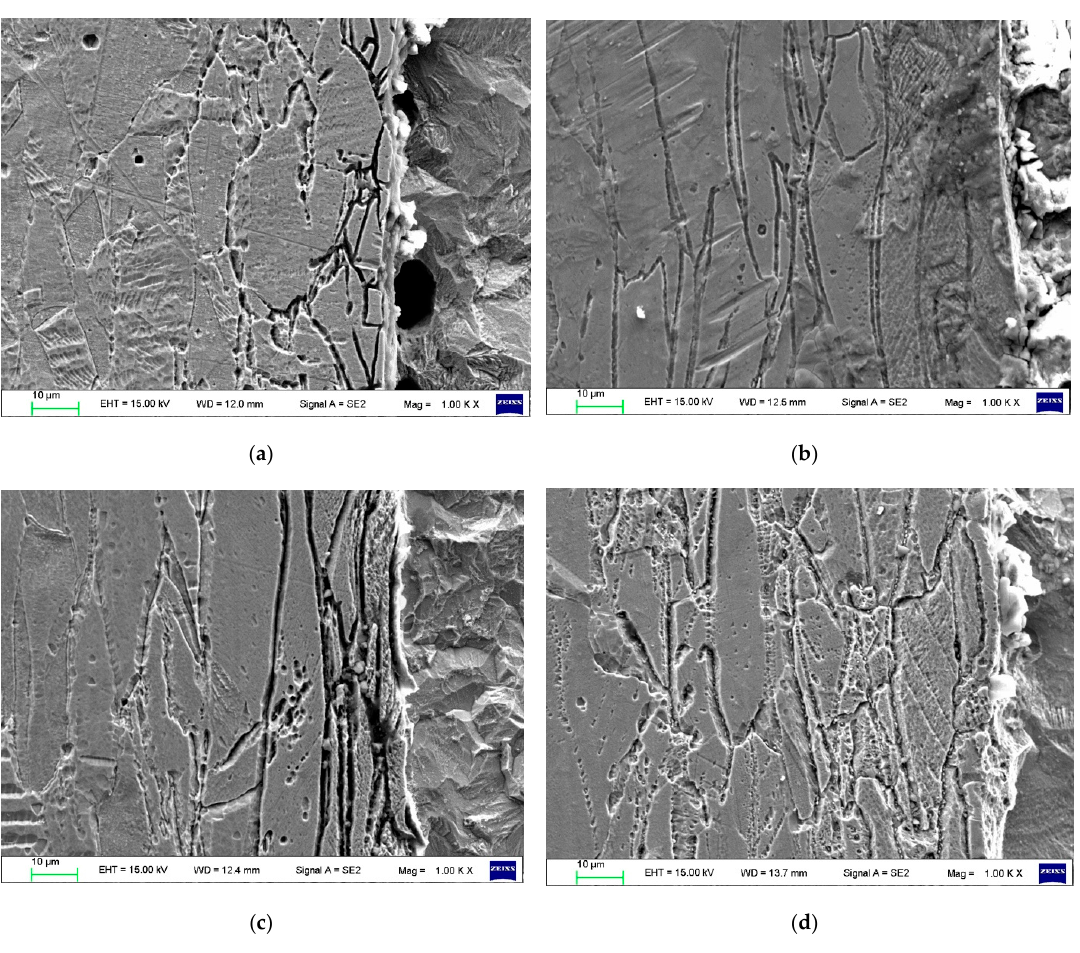
Figure 3. Microstructures of the 316L side and SEM results: ( a ) 500 °C; ( b ) 600 °C; ( c ) 800 °C; ( d ) 1000 °C.